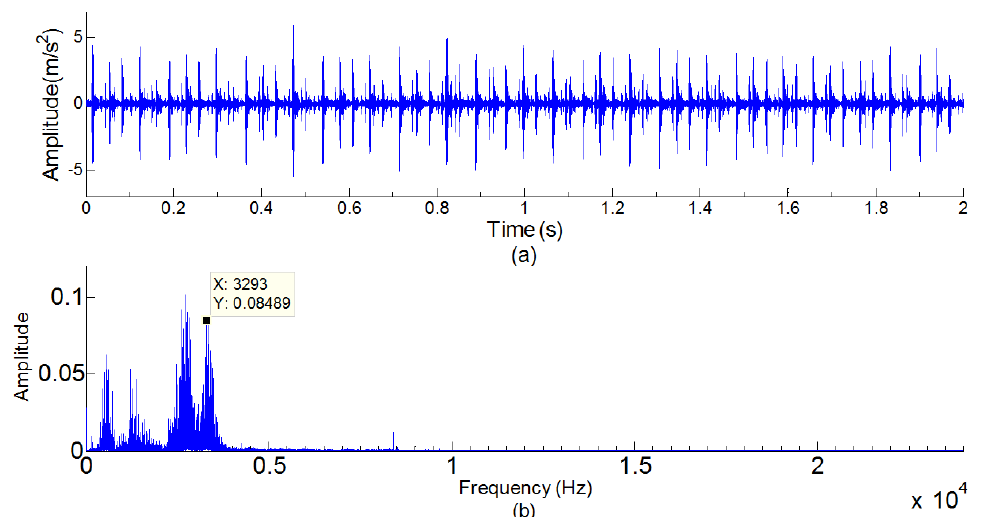
Figure 6. Experimental bearing vibration signal and its spectrum. ( a ) Experimental bearing vibration signal; ( b ) spectrum of the bearing vibration signal.